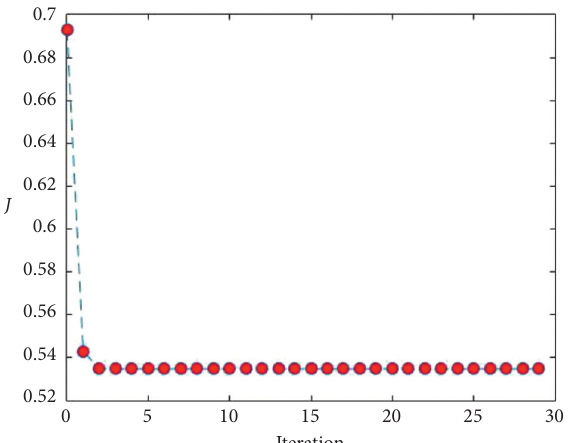
Figure 8: BL (binary logit) model likelihood function optimization.